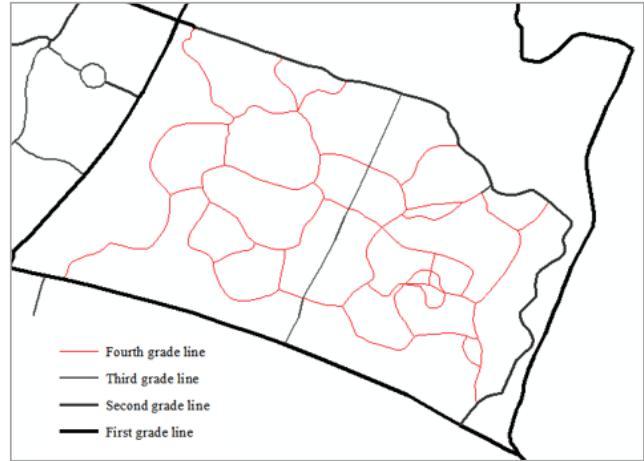
Figure 4. The small and simple paths in a scenic area and the fourth-grade red lines are similar to narrow winding trails of a garden or forest.